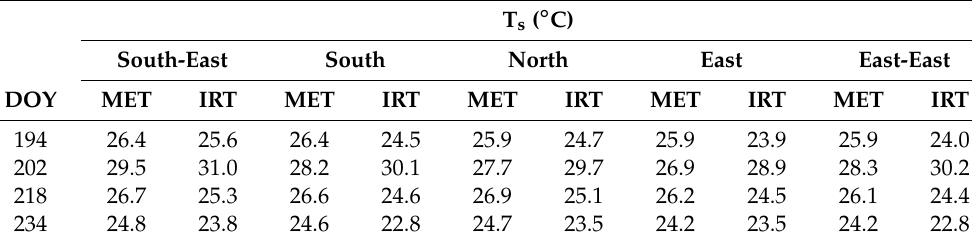
Table 4. Ts values from the METRIC (MET) model and infrared thermometer (IRT) at five locations and